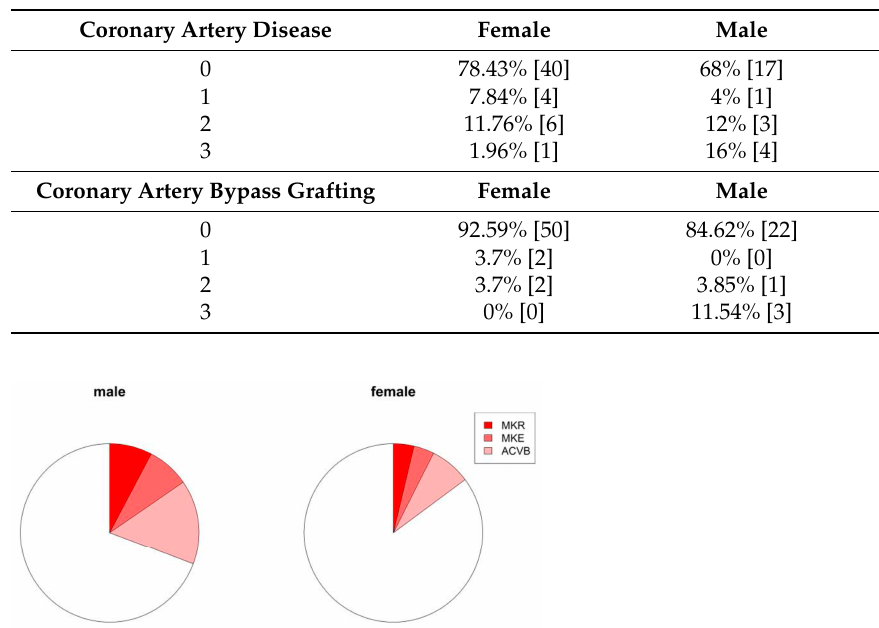
Table 3. Concomitant coronary artery disease.